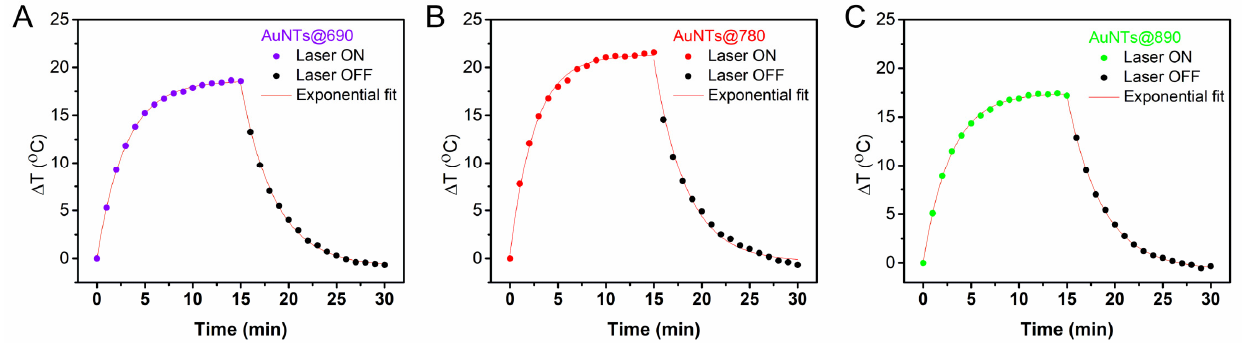
Figure 3. The thermal curves of the AuNTs with LSPR at ( A ) 690, ( B ) 780, and ( C ) 890 nm, respec- tively.